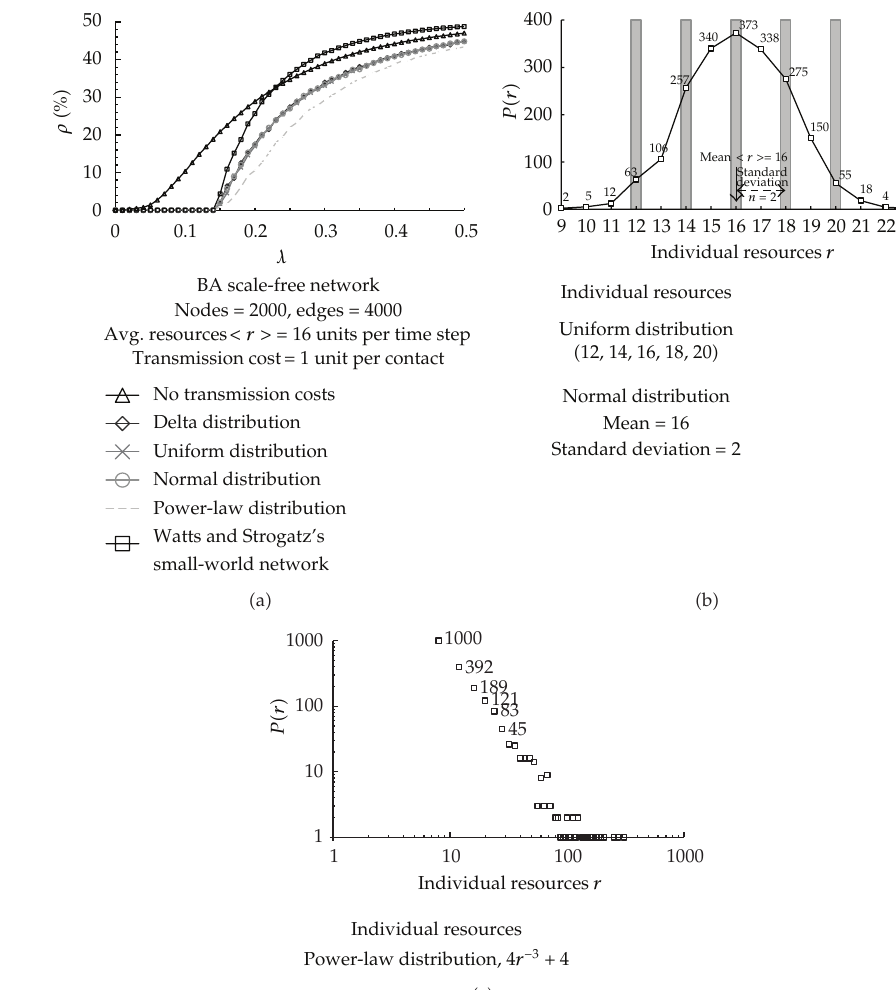
average value (cid:3) r (cid:4) of the statistical distribution derived from the real-world scenario being